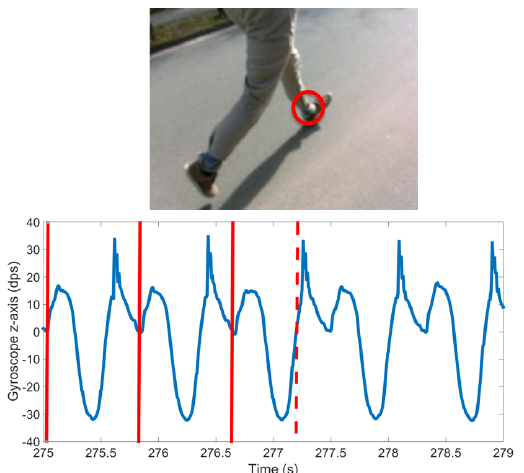
Figure 4. Image of manual labeling tool showing that the signal is the gyroscope sagittal plane (GZ, blue line) of the left foot. Solid vertical lines represent the already annotated cycles. The dashed vertical line corresponds to the shown camera frame. The circle in video frame shows the sensor